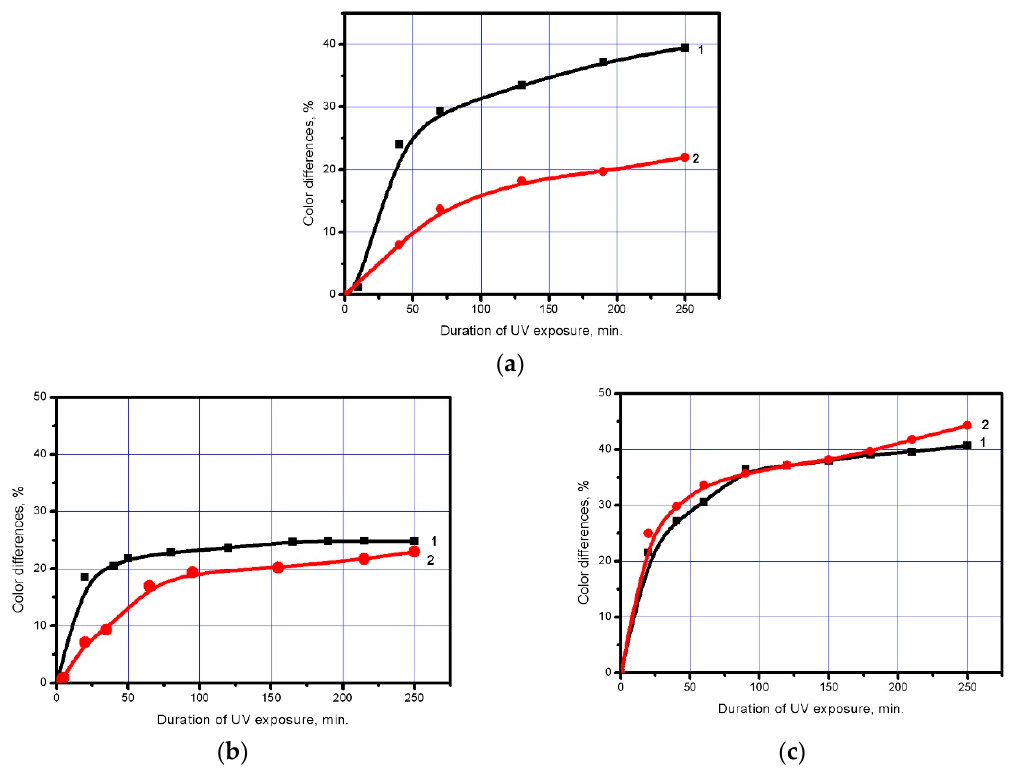
Figure 6. Differences in eosin colour before washing (1) and after washing (2) in the polyester fabric activated with NaOH (3.75 g/L). Fabric with a coating based on (8 g/cm 2 ): ( а ) Undoped Т iO 2 nanoparticles; ( b ) Т iO 2 nanoparticles doped with iron; ( c ) Т iO 2 nanoparticles doped with silver.